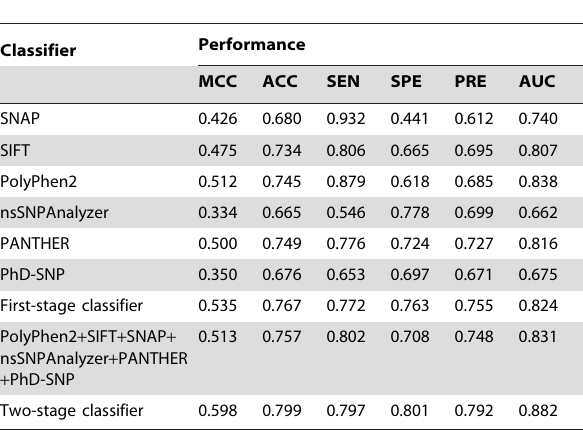
Table 3. Prediction performance of the first-stage and two- stage FunSAV classifiers in comparison with six other prediction